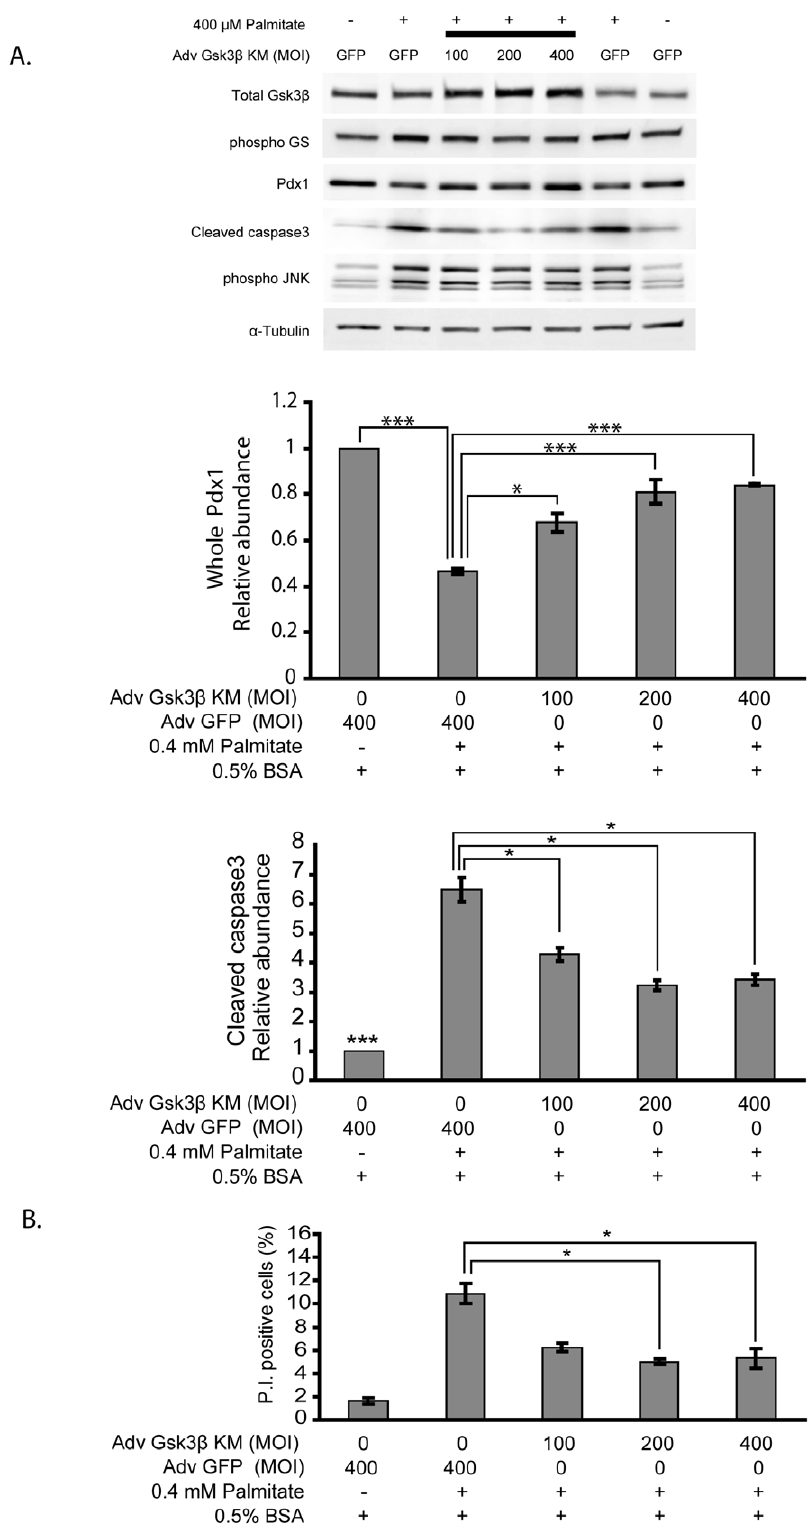
Figure 7. Inhibition of Gsk3 b protects against glucose and palmitate-induced apoptosis in MIN6 cells. MIN6 cells were infected with 100, 200, or 400 MOI of adenovirus expressing a catalytically inactive mutant of the human Gsk3 b (Adv-Gsk3 b KM) or adenovirus expressing GFP (Adv- GFP) 24 hours prior to palmitate treatment. Cells were treated with 25 mM glucose and with either 0.5% BSA or 400 m M PA + 0.5% BSA for 24 hours. A GFP control was placed on either end of the blot to facilitate comparison of control and Adv-Gsk3 b KM. ( A ) Western blots using the indicated antibodies, with relative expression of Pdx1 normalized over a -Tubulin, and expression levels of cleaved Caspase3 normalized over a -tubulin. ( B ) Percentage of Propidium Iodide incorporation (n=3, means 6 S.E.M., *p , 0.05, *** p , 0.001).